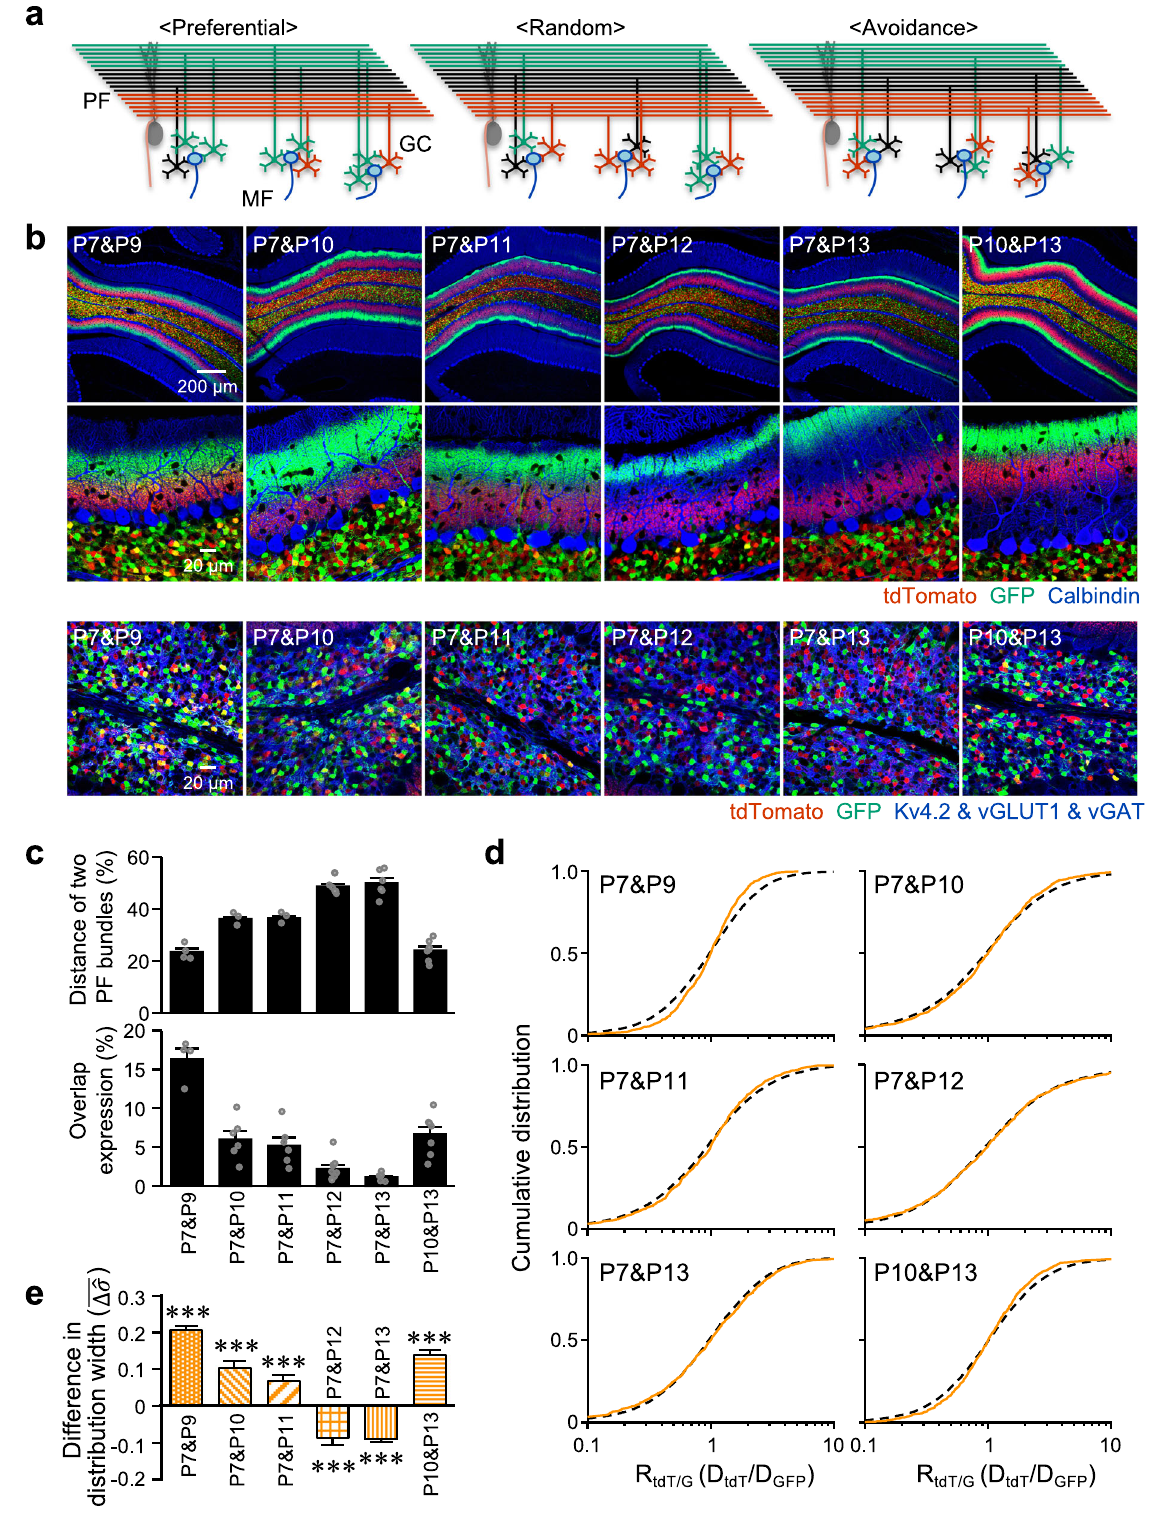
connection than the random connection (Fig. 4b), con fi rming three different patterns of connections. The severer level of preferential or avoidance connections was also made by repeating more permutation trials (lighter magenta or cyan in Fig. 4b). In the experiments, single injection of AAV-GABR α 6-GFP resulted in GFP expression in approximately 30% of GCs (Fig. 4c, open bars) and existence of GFP-positive dendrites in 81.0 – 84.1%